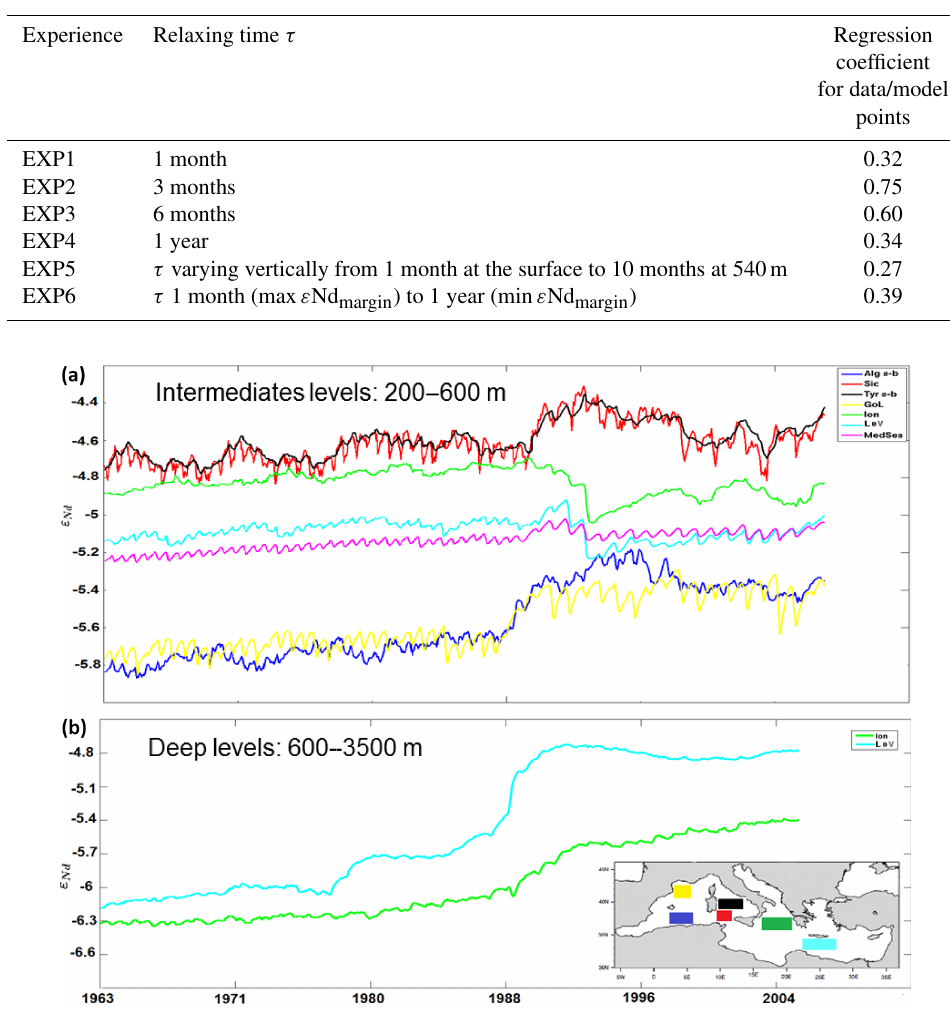
Figure 7. The ε Nd evolution from EXP2 ( τ = 3 months) at the intermediate level in (a) (average depth between 200 and 600m), and for the deep levels in (b) (average depth between 600 and 3500m). In the Gulf of Lion (yellow), Algerian sub-basin (blue), Levantine s-b (cyan), Ionian s-b (green), Strait of Sicily (red), Tyrrhenian s-b